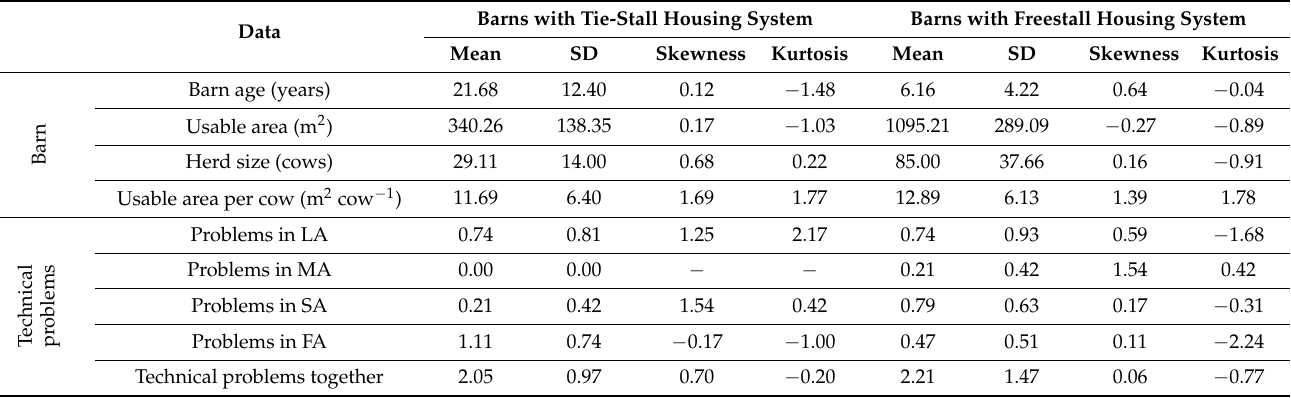
Table 4. Descriptive statistics concerning technical problems in the investigated dairy farms, including number of technical problems per